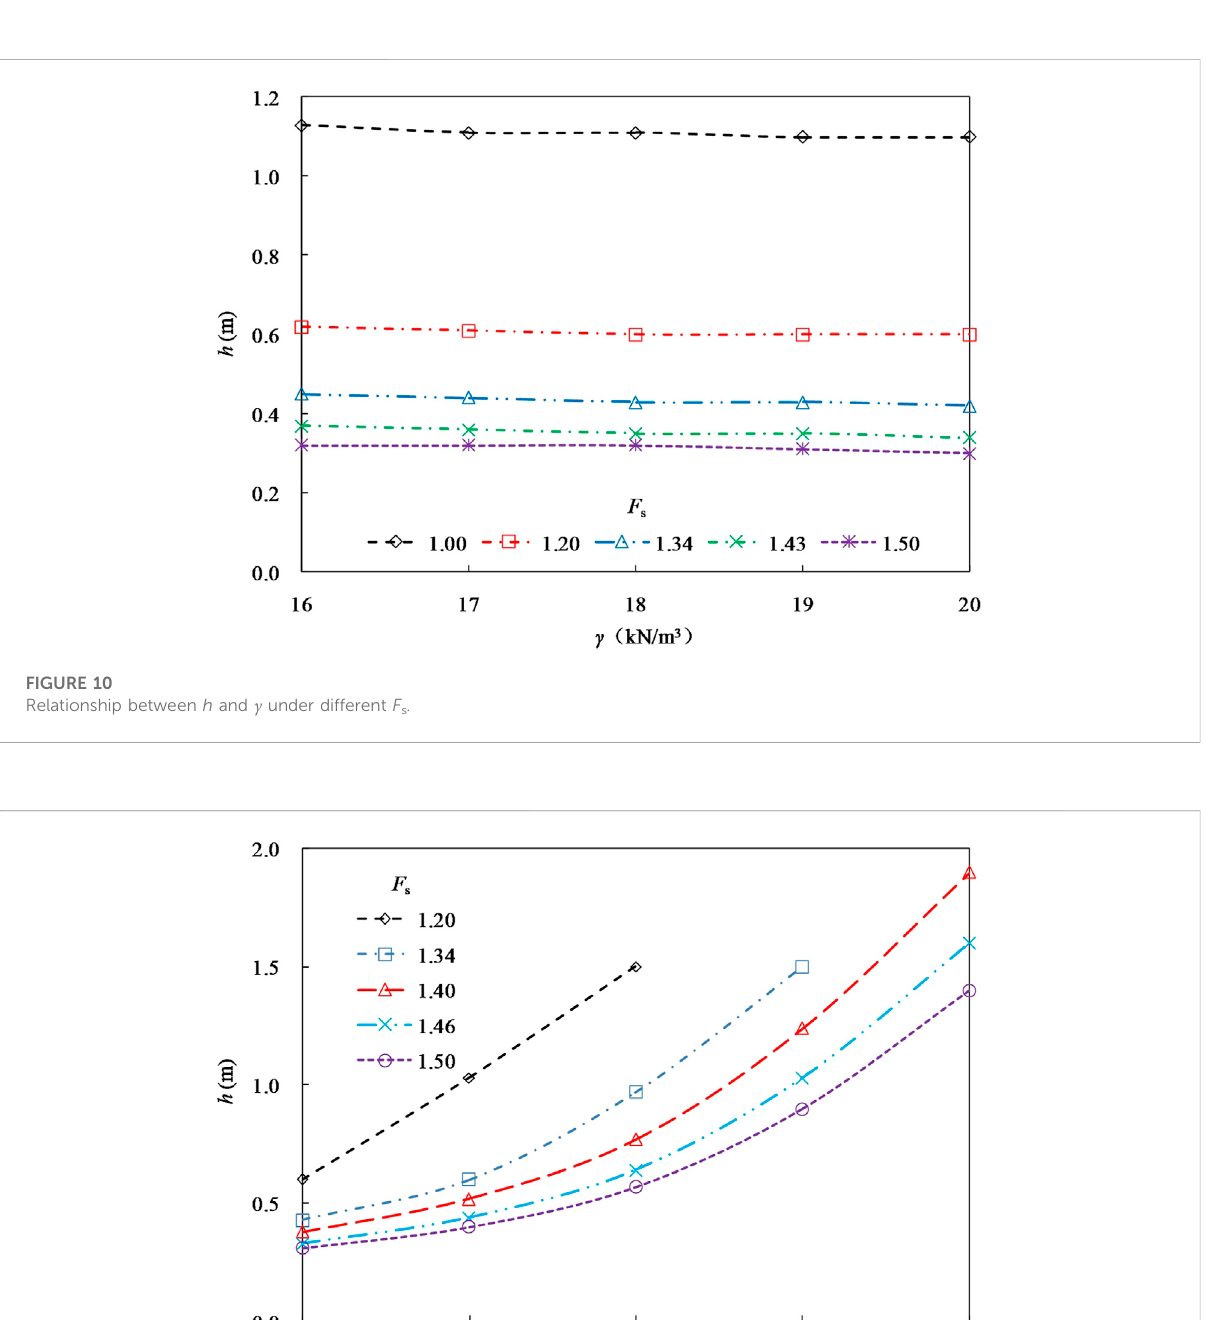
seismic coef fi cient increases. With the rise of the designed safety factor, the decrease gradient reduces gradually. Under high safety factors, the vertical seismic coef fi cient has a minor effect on the reinforcement spacing.